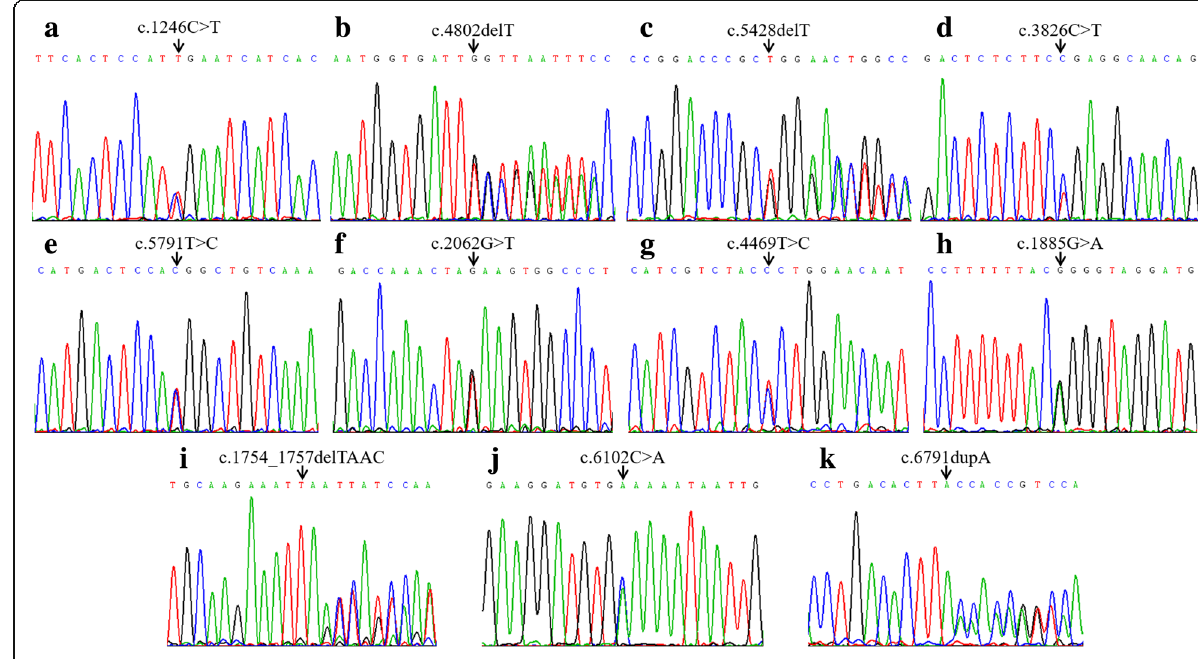
Fig. 3 Mutations identified in the probands of Families 1 – 11. Mutations detected by Sanger sequencing: a : Patient 1, c.1246C>T; b : Patient 4, c.4802delT; c : Patient 7, c.5428delT; d : Patient 11, c.3826C>T; e : Patient 13, c.5791T>C; f : Patient 15, c.2062G>T; g : Patient 16, c.4469T>C; h : Patient 17 c.1885G>A; i : Patient 18, c.1754_1757delTAAC; j : Patient 19, c.6102C>A; k : Patient 20, c.6791dupA